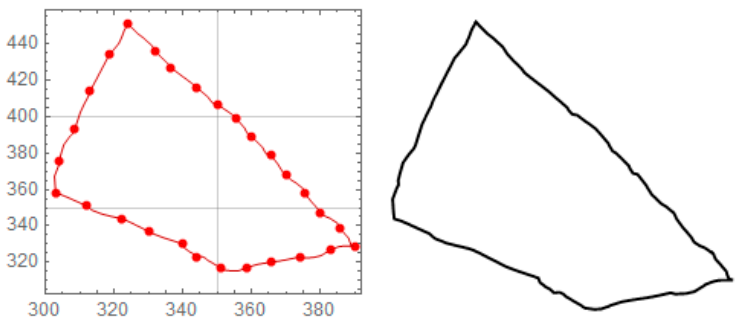
Figure 3. Pore shape reconstruction based on FESEM and STEM microstructure characterization.